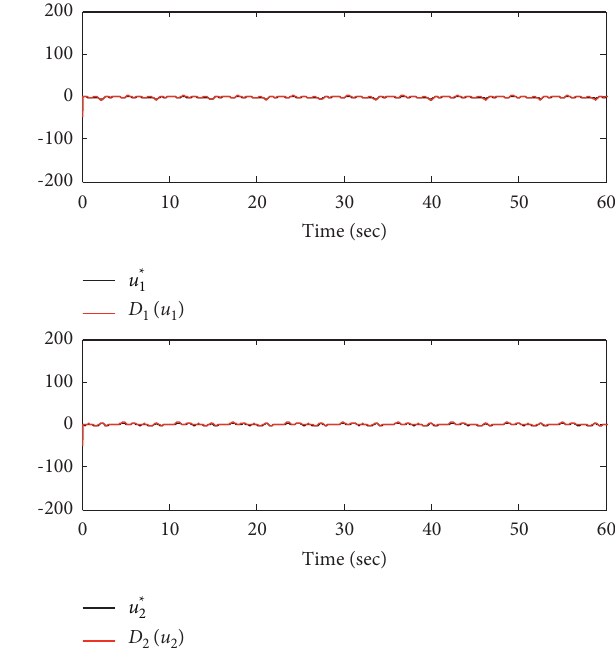
Figure 1: Trajectories of outputs Y